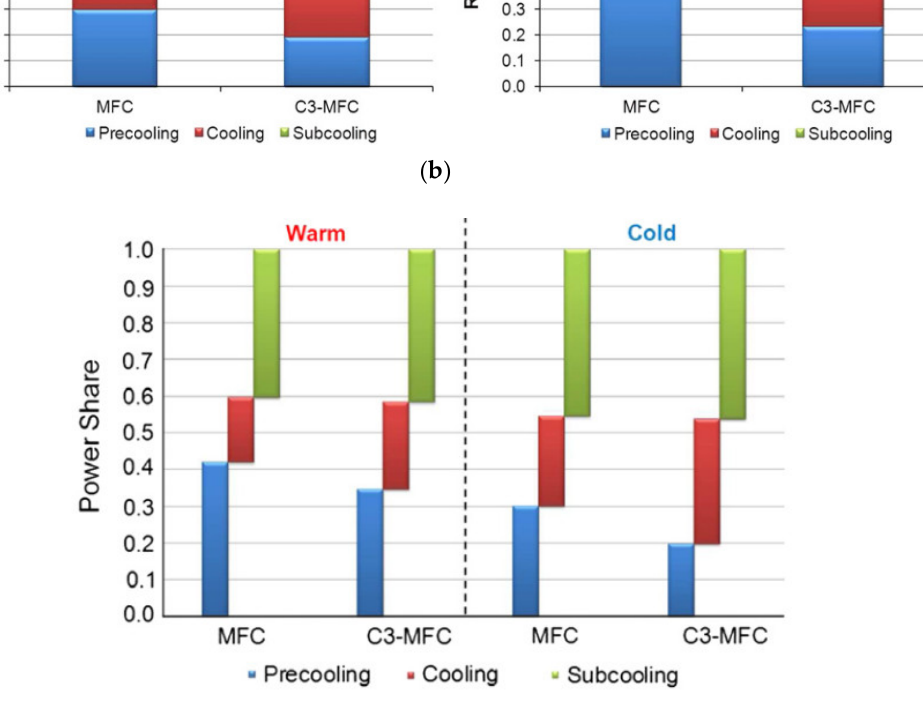
Reproduced with permission from MDPI. Figure 9. Variation of the specific energy consumption of optimized process with N compressor stages and ambient seawater temperature T 0 . Dashed lines are mixed fluid cascade (MFC) processes [47]. Cascade liquefaction process with three cycles of mixed refrigerants has great poten- tial for large-scale LNG production, but also consumes a lot of energy. Whereas the cool- ing cycle number can enhance the thermal efficiency of the process, it increases both the number and cost of components. Therefore, to address this issue, an integrated-design process is proposed to integrate MFC process with the recovery of natural gas condensate [48]. The integration of the process does not need a reboiler and condenser, reducing the power required for the refrigeration system. On this basis, the addition of a nitrogen re- jection unit eliminates the negative impact of nitrogen on the heating value of the fuel [44]. As shown in Figure 10, MFC-NGL-NRU uses a de-ethanizer with multiple side streams, and its top outlet is used as a low-temperature stream to pre-cool the system inlet feed. And the mixed refrigerant cycle in it provides the required cooling energy for natural gas